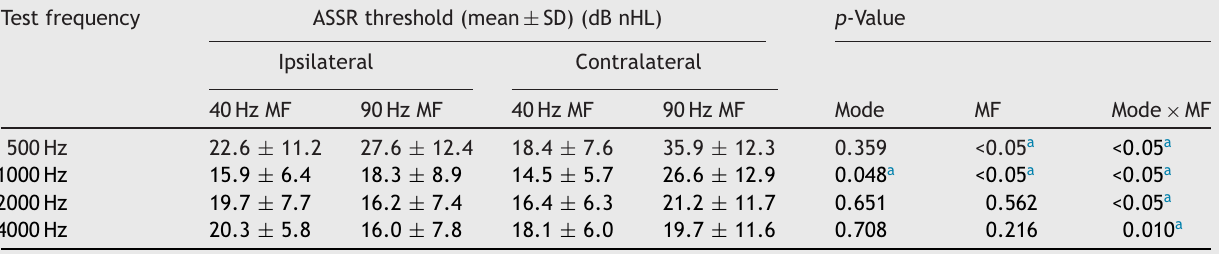
Table 1 Descriptive and inferential statistical analyses of ASSR thresholds (in dB nHL) for different modes of recordings and modulation frequencies at specified test